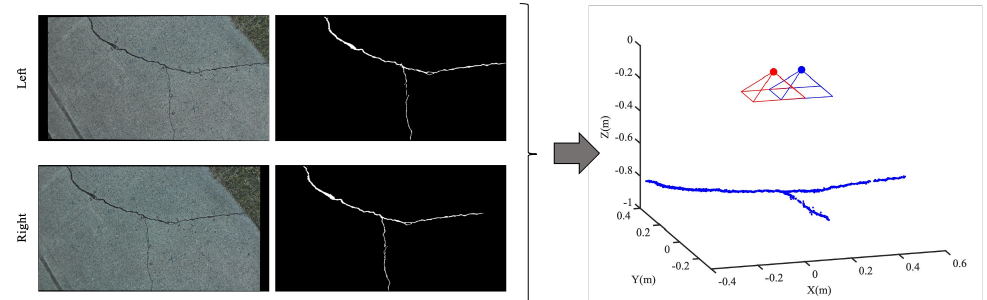
Figure 19. 3D Reconstruction, matching approach. The red and blue pyramids show the left and right camera